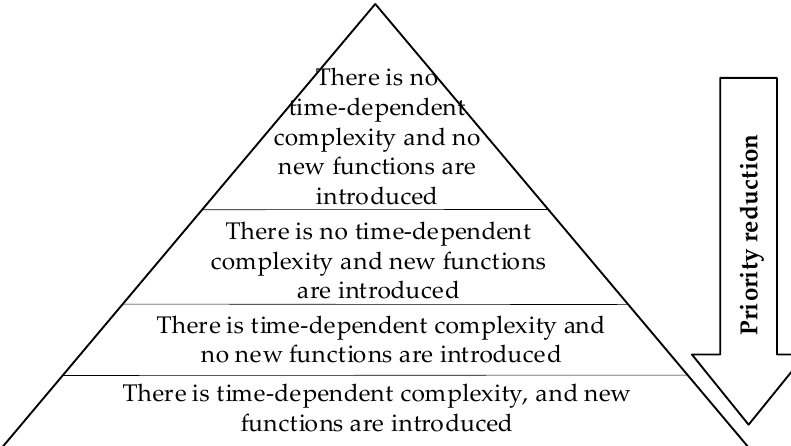
Figure 5. Design scheme ranking principle.